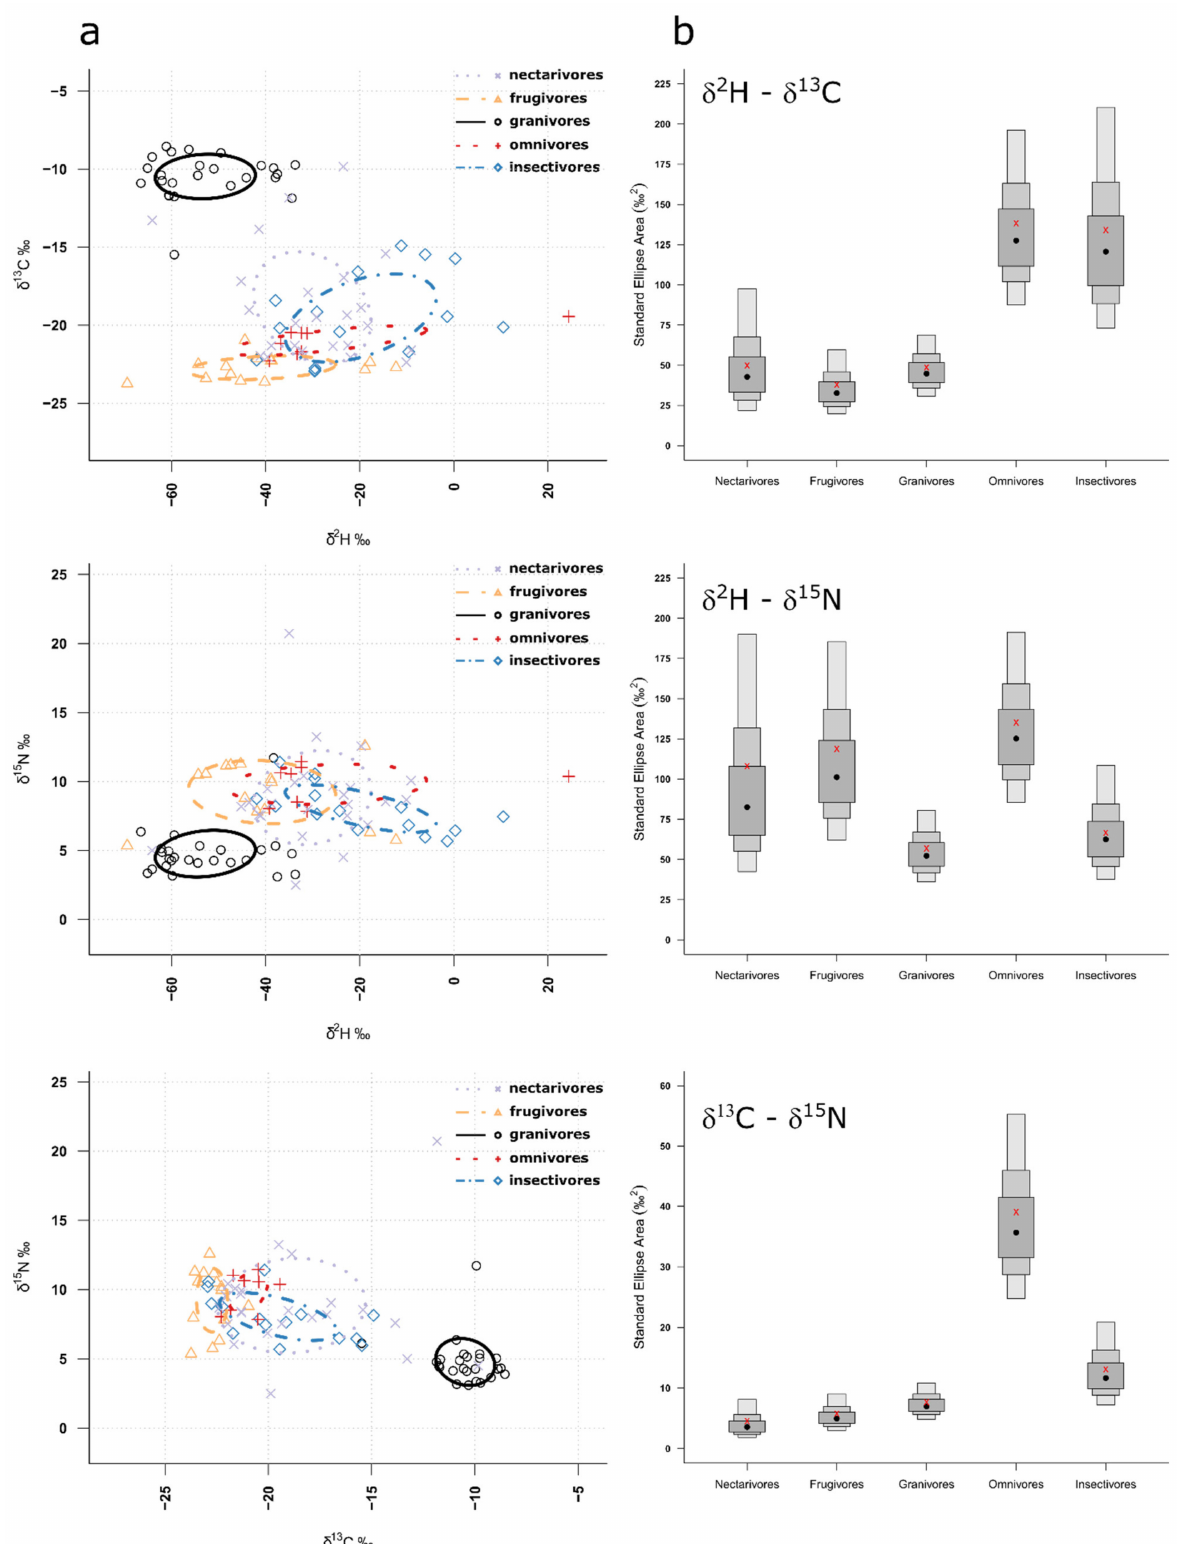
Figure 3. ( a ) Independent calculated ellipses containing 40% of the isotopic data for the five different guilds for all combinations of isotopes. ( b ) Posterior distributions of isotopic niche size (Bayesian Standard Ellipse Areas) for the five different feeding guilds for all combinations of isotopes. Grey boxes represent 40% (dark shading), 75% (medium shading) and 95% (light shading) credible intervals, with red crosses designating the model values and black dots the